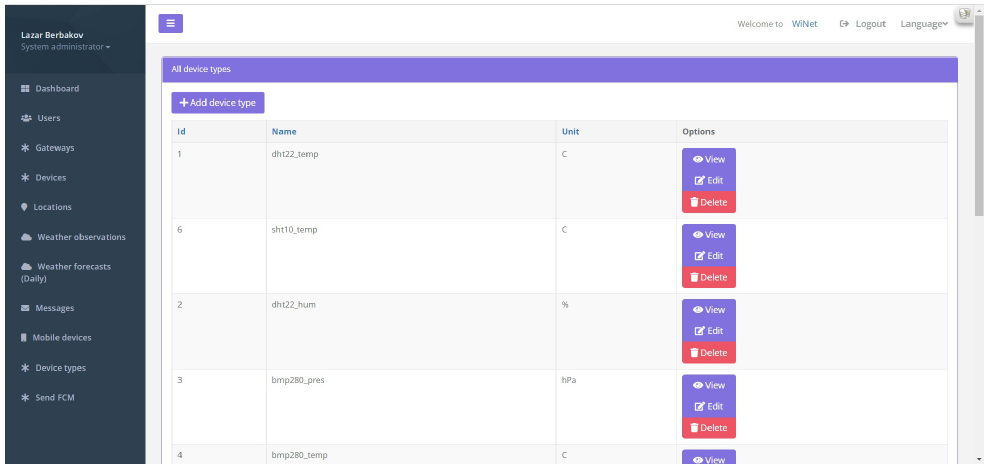
Figure 10. The Winet Web application—sensor type